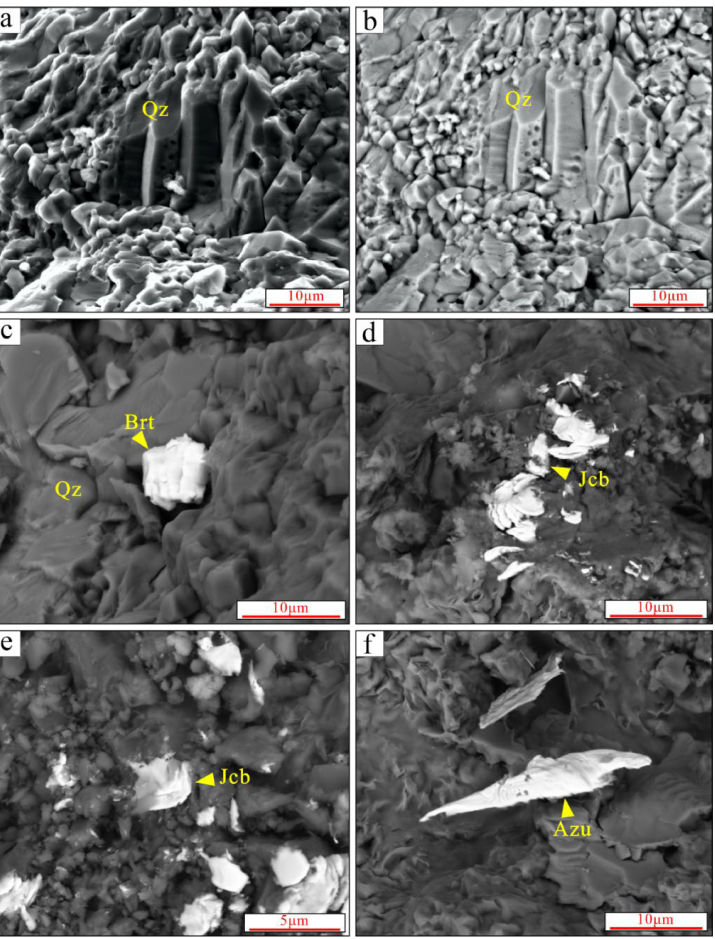
Figure 7. Scanning electron microscope images of chert nodules in the Lucaogou Formation, Junggar Basin. ( a ) Quartz is crypto-microcrystalline with relatively poor crystallinity, SE image; ( b ) BSE image corresponding to ( a ); ( c ) authigenic barite in chert nodule, BSE image; ( d , e ) authigenic jacobsite in chert nodule, BSE image; ( f ) authigenic azurite in chert nodule, BSE image. Qz = quartz; Brt = barite; Jcb = jacobsite; Azu =